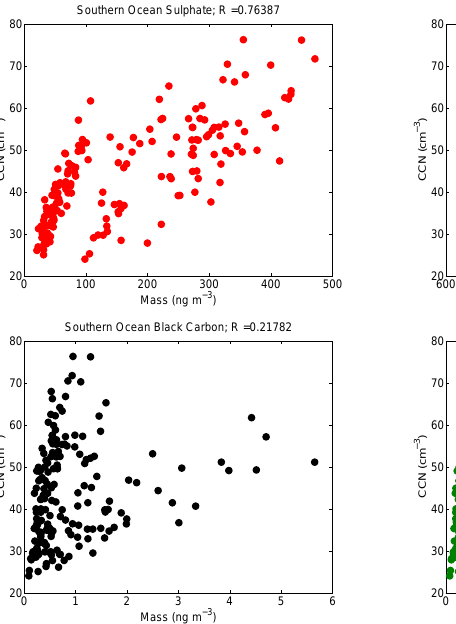
concentration, with a correlation coefficient of just 0.06. The presence of carbonaceous aerosol in the soluble ac- cumulation mode indicates that a significant proportion of CCN in the region has been transported from the west coast of North and Central America via prevailing north-easterly trade winds. Since carbonaceous aerosol makes such a large